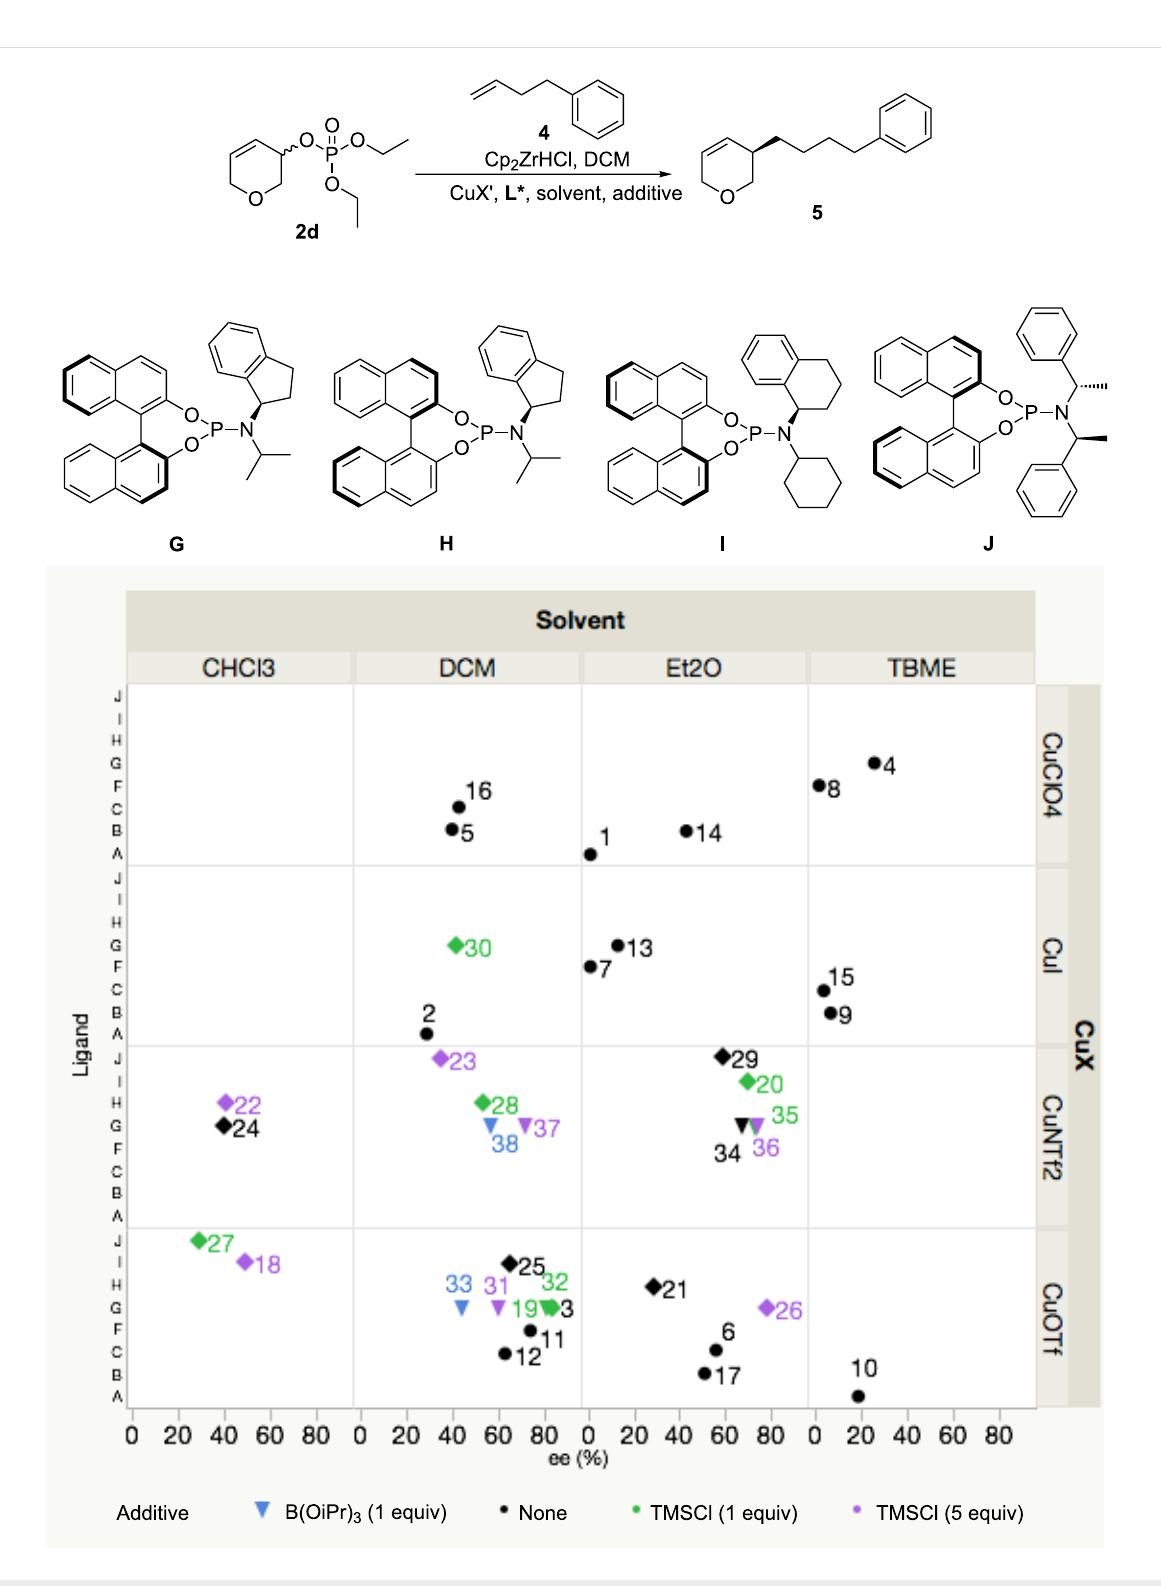
Figure 1: DoE from 3,6-dihydro-2 H -pyran-3-yl diethyl phosphate ( 2d ). Conditions: 4-phenyl-1-butene (2.5 equiv), Cp 2 ZrHCl (2.0 equiv), 2d (1.0 equiv), Cu L* as specified (0.1 equiv), additive as specified (1.0 equiv or 5.0 equiv), in specified solvent (2.0 mL), room temperature. ee deter- mined by HPLC. For more information on the procedures see Supporting Information File 1. ● (wave 1, entries 1–17), ♦ (wave 2, entries 18–30), ▼ (wave 3, entries